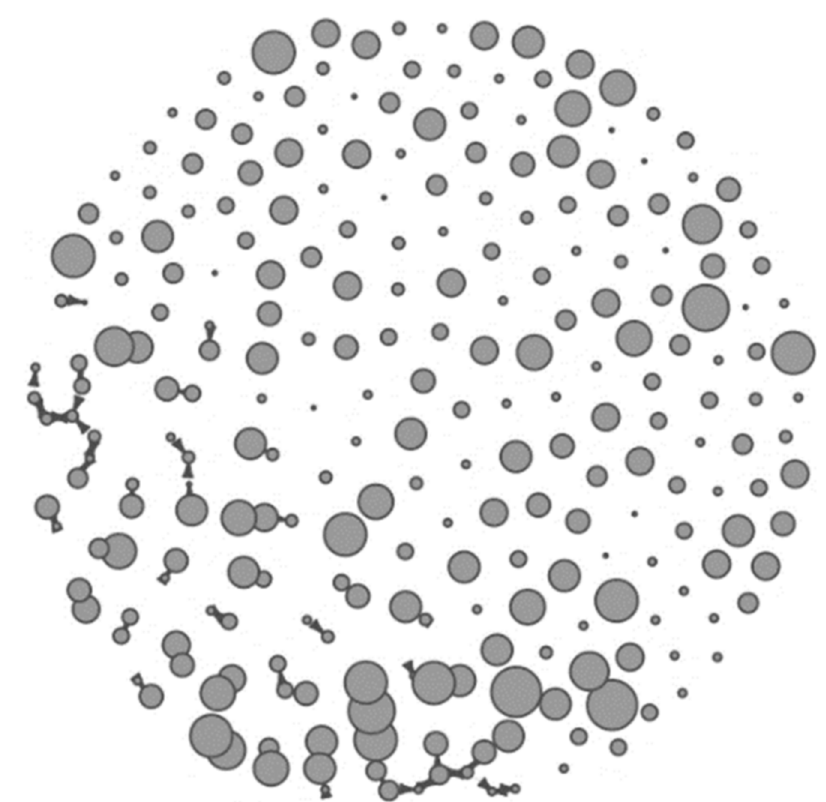
Figure 1. Visual representation of confidant network. Nodes represent participants, and ties between nodes represent one or two-way confidant relational ties, where an arrow indicates a direction. Nodes without any tie were isolates. Node size corresponds to the participants’ logical memory score (larger nodes reflect better